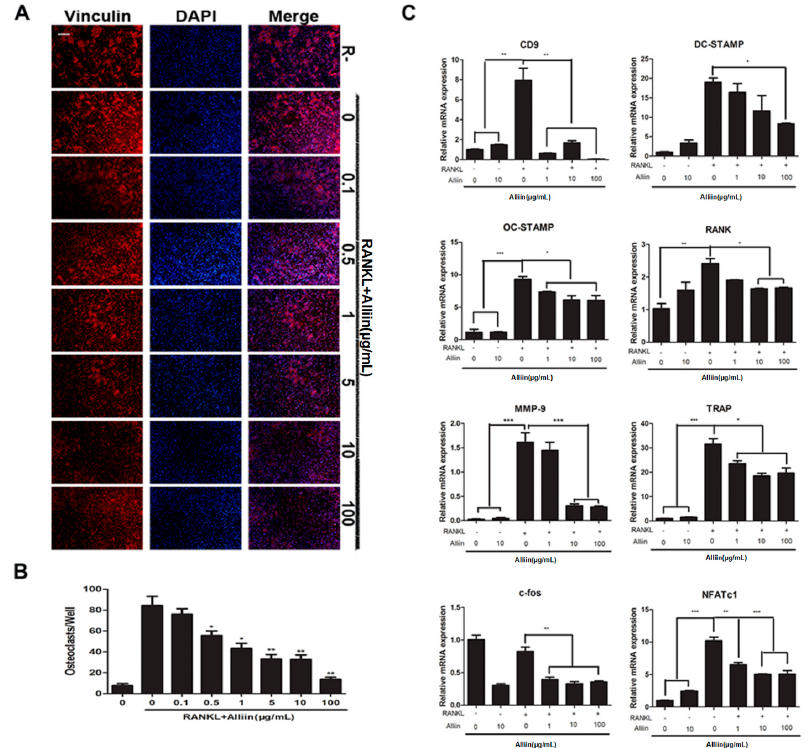
Figure 3. Alliin inhibited RANKL-induced osteoclast fusion and differentiation in a dose-dependent manner. ( A ) RAW264.7 cells were pretreated with RANKL (50 ng/mL) and M-CSF (50 ng/mL) for about 72 h along with a range of alliin concentrations (0, 1, 10 µg/mL), following focal and adhesion staining, and finally photographed. The nuclei were stained for double immunofluorescence microscopy by DAPI ( blue ) and Vinculin monoclonal antibody ( red ). Each experiment was performed thrice. Scale bar was at 200 µm; ( B ) the quantitative test for the TRAP (+) cells having multiple nuclei in each well of 96-well plate; and ( C ) the total RNA extracted from RAW264.7 cells during RANKL-induced osteoclastogenesis treated with RANKL (50 ng/mL) and M-CSF (50 ng/mL) for 72 h with varying doses of alliin (0, 1, 10, 100 µg/mL). Relative mRNA expression levels of NFATc1, c-Fos, MMP-9, CD9, DC-STAMP, OC-STAMP, TRAP, and RANK against GAPDH are shown. Data in the figures represent the averages ± SD. * ( p -value < 0.05); ** ( p -value < 0.01) or *** ( p -value < 0.001) based on one way ANOVA.